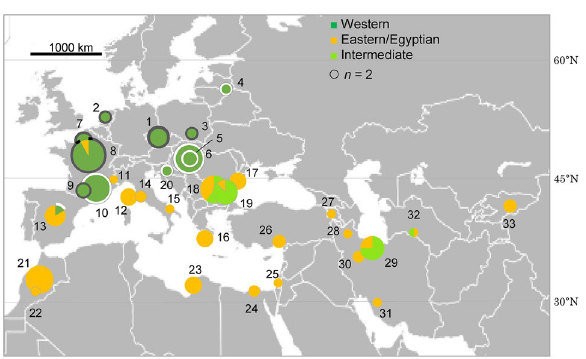
Figure 2. Geographic distribution of mitochondrial clades of Hypera postica in its native range. Pie chart sizes for clades are proportional to sample sizes. Wolbachia infection (dark gray ring: infected; white (partial) ring: uninfected) is only indicated for the Western clade individuals because none of the Egyptian/Eastern clade or the intermediate clade were infected. The background map was obtained from Fotolla, https:// stock. adobe. com/ jp/